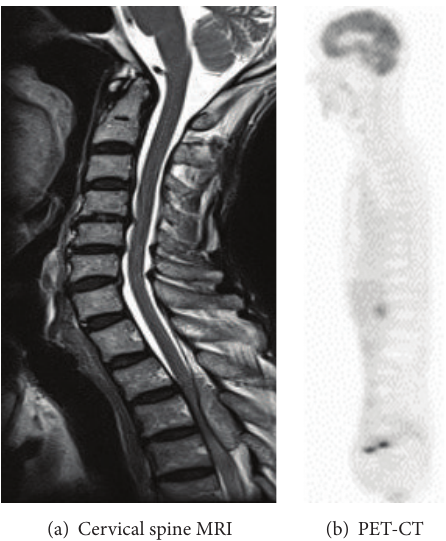
Figure 2: No apparent mass lesions other than the thoracic spinal epidural mass were